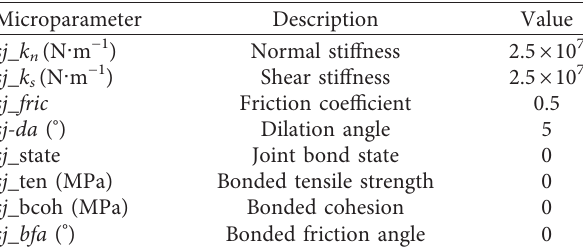
Table 9: Microparameters of the SJM after calibration.